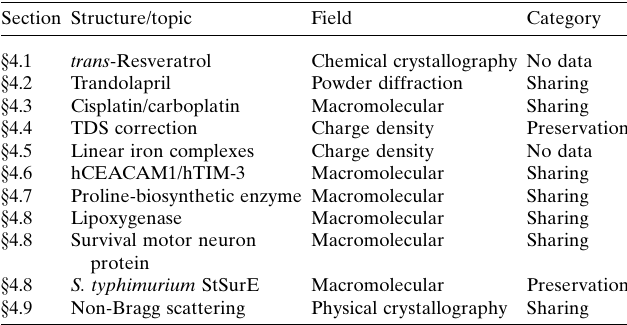
Table 1 Summary of case studies in this article. The categories ‘sharing’, ‘preservation’ and ‘no data’ correspond to the benefits or hindrances to scientific progress described in the final sentence of x 1.